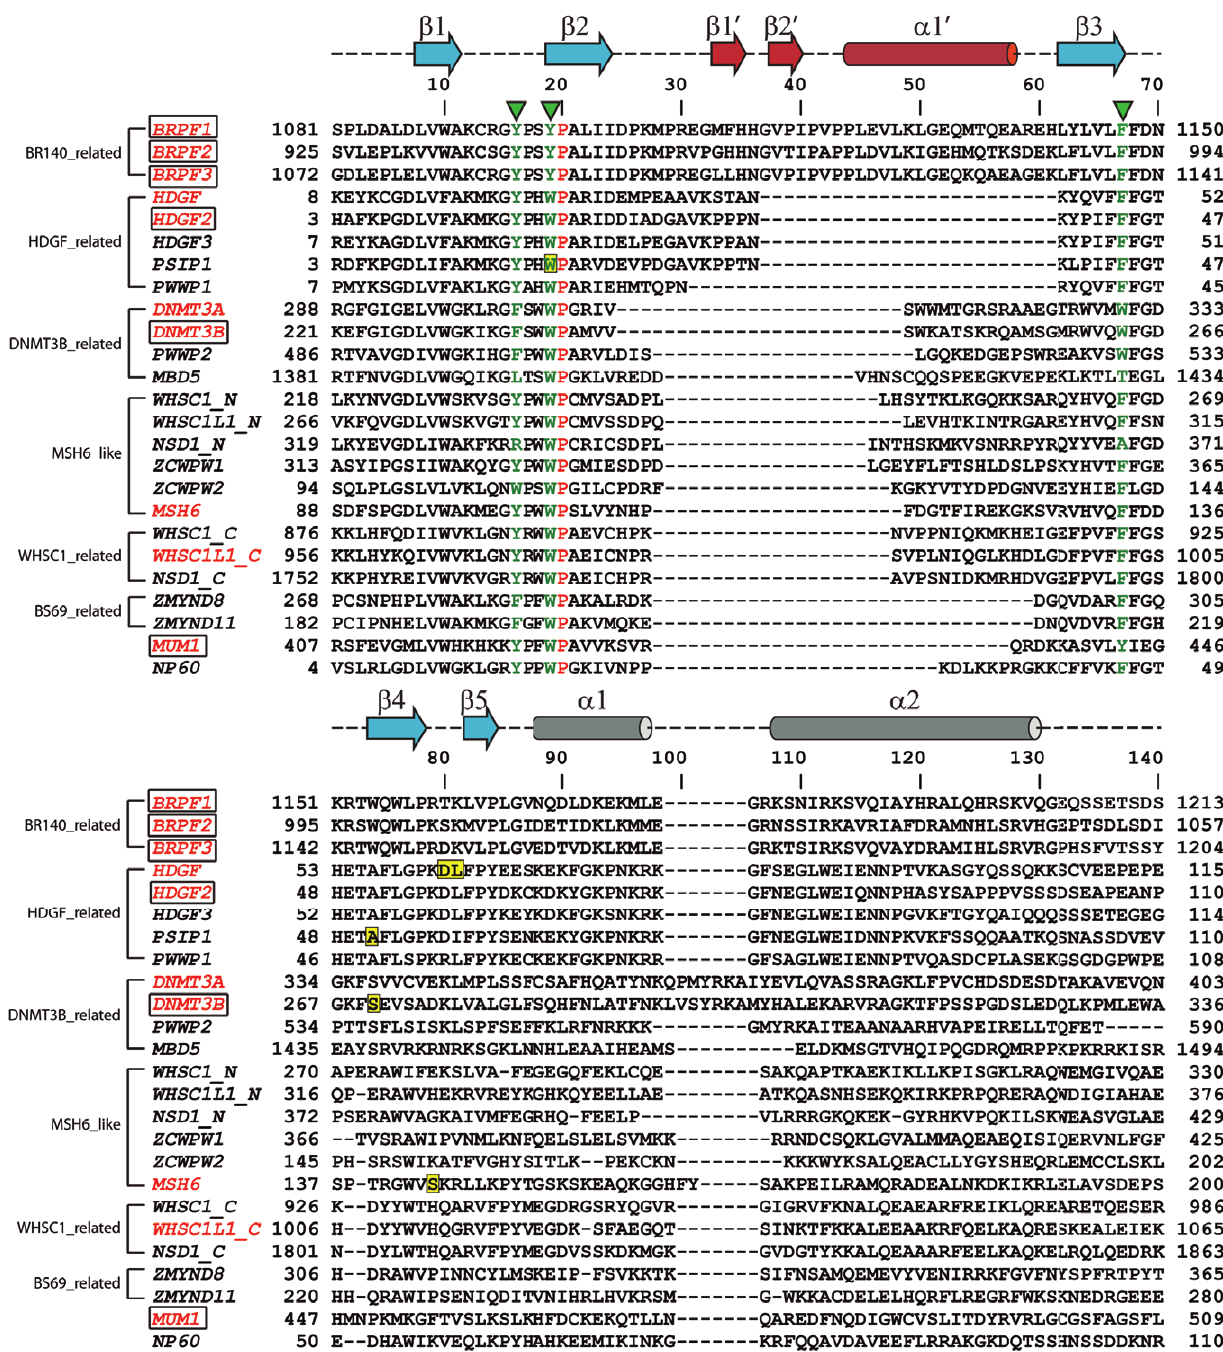
Figure 1. Structure-based sequence alignment of human PWWP domains. There are over 20 PWWP containing proteins in the human genome, which can be categorized into 6 classes. We solved crystal structures of PWWP domains from 7 different human proteins (colored in red and boxed). The structures solved by other labs are colored in red. All of these PWWP domains contain an aromatic cage formed by three aromatic residues (labeled by green triangles) except MBD5 and the N-terminal PWWP domain in NSD1. The identical residues in the alignment are colored in red. The secondary structure elements of BRPF1 are shown on top of the alignment, with cylinders representing helixes and arrows representing strands. The alignment was generated by using Clustal W assisted with manual adjustment.